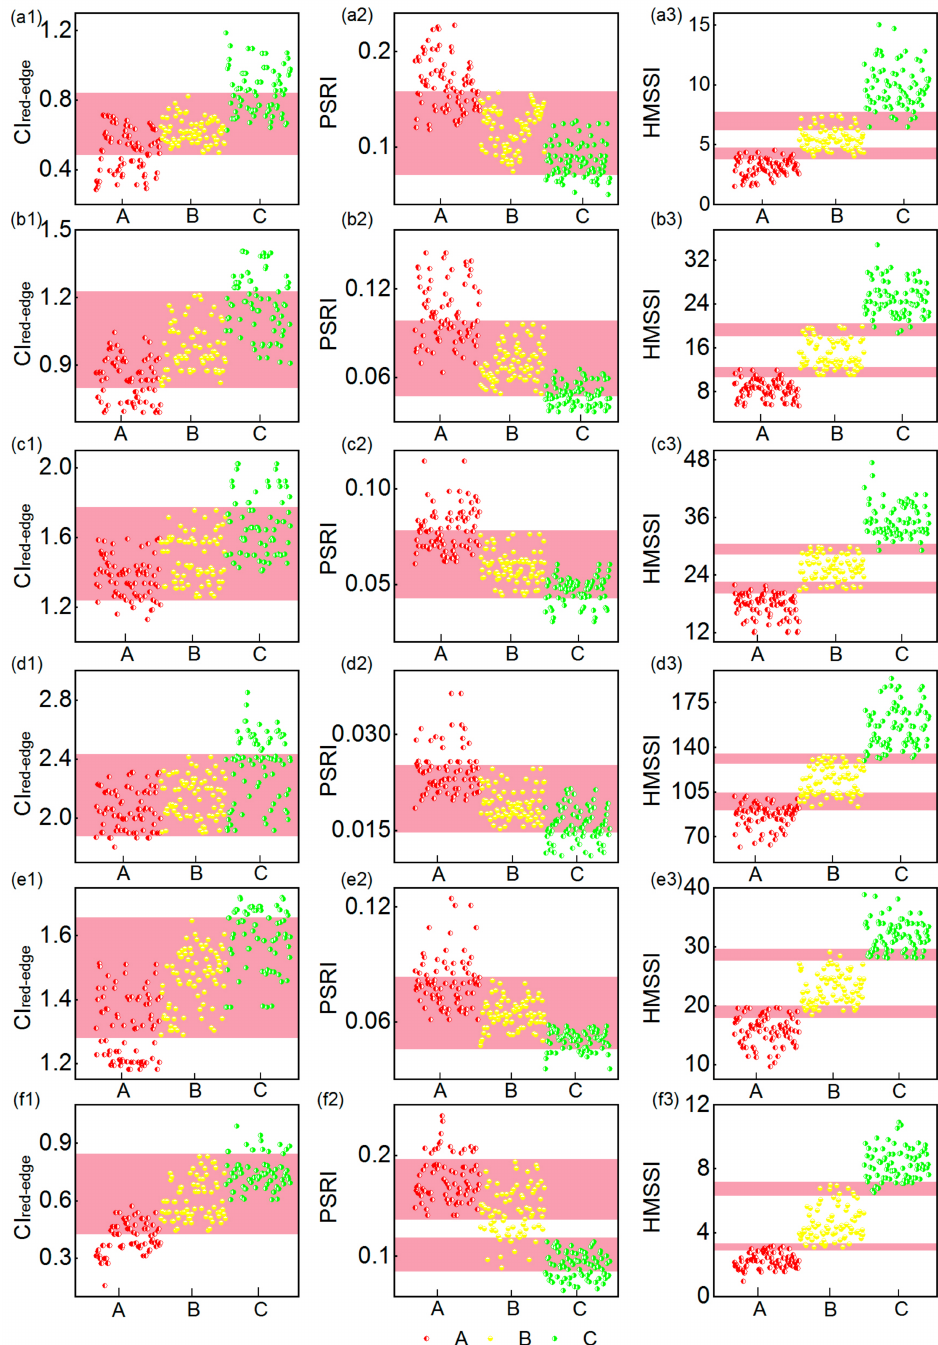
Figure 2. Rice under different stress levels obtained using the three indices at different growth stages. ( a1 – f1 ) The distributions of CI red-edge under different stress levels at different growth stages; ( a2 – f2 ) the distributions of PSRI under different stress levels at different growth stages; ( a3 – f3 ) the distributions of HMSSI under different stress levels at different growth stages. Note: the pink zone represent the overlapping portion of different stress